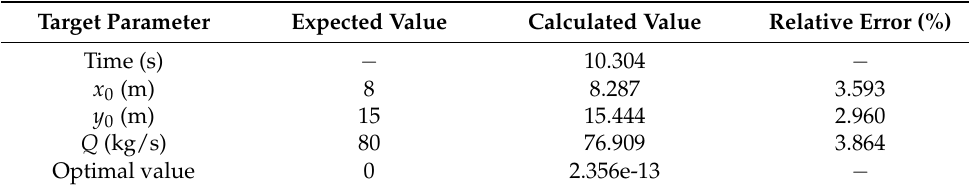
Table 9. Qualitative results table of OMO algorithm under 9 sensors.